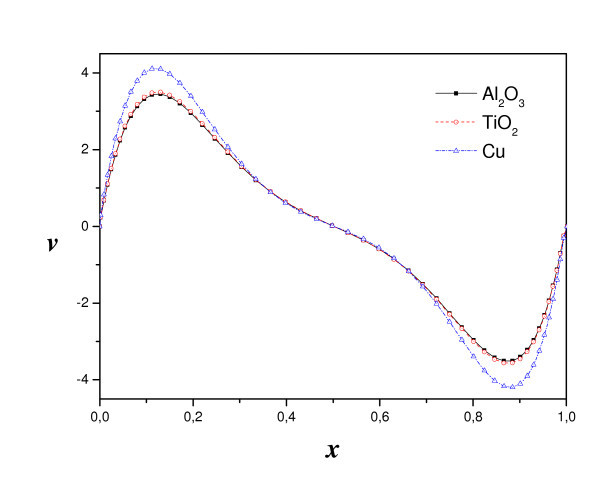
Vertical velocity on the horizontal mid-plan (RT = 104, φ = 2%, Le = 3 and Sr = 2%).